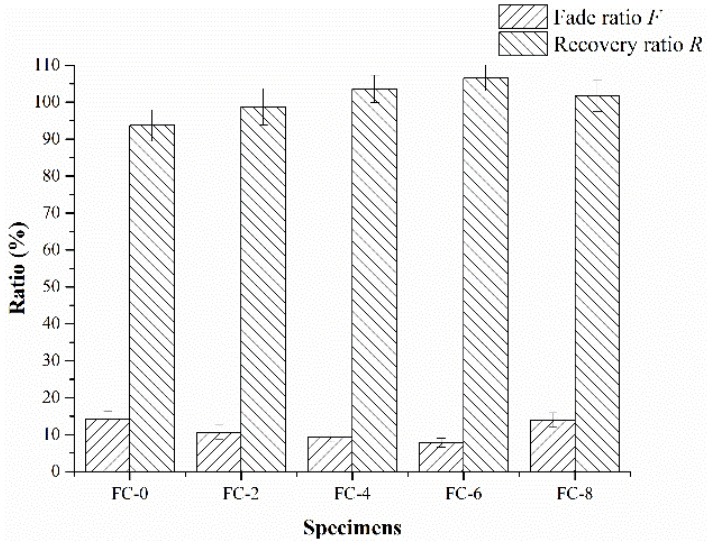
Figure 6. Fade ratios and recovery ratios of the friction composites.